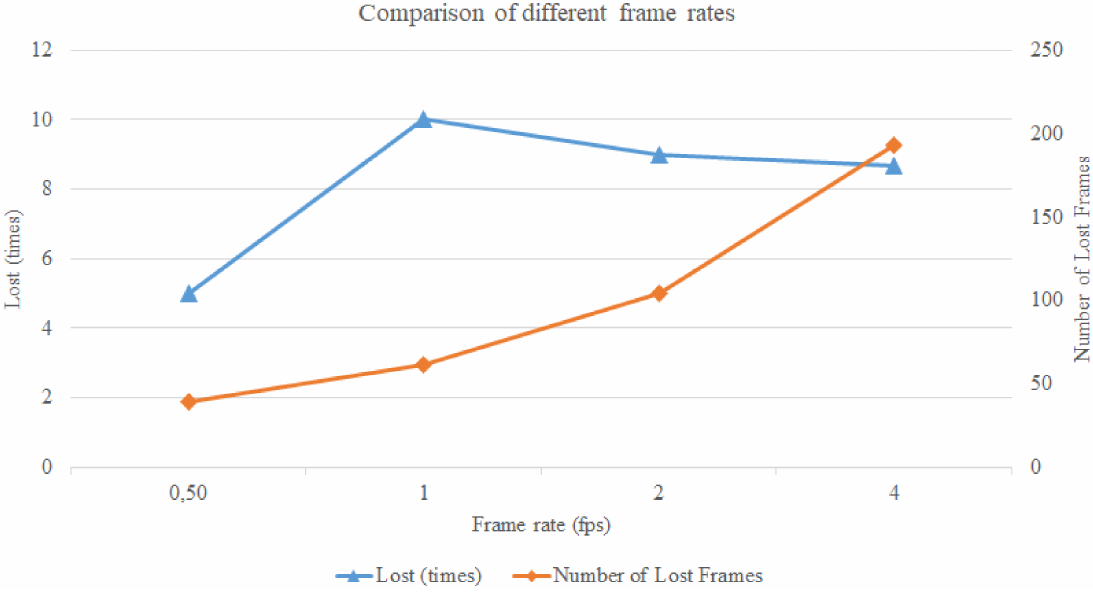
Figure 8. The influence of the frame rate on how many times the track gets Lost and on the Number of Lost Frames